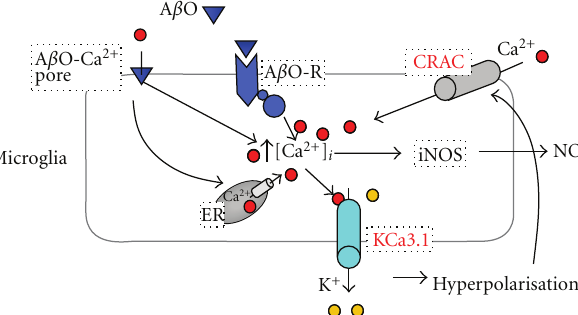
Figure 1: KCa3.1 regulates microglial activation by modulating Ca 2+ influx. A β O initiates an increase of intracellular Ca 2+ either directly by forming a Ca 2+ -permeable membrane pore (A β O-Ca 2+ pore) [11, 12] or indirectly through interaction with a receptor (tentatively termed A β O-R). Intracellular Ca 2+ activates KCa3.1 to induce K + e ffl ux. The resulting hyperpolarisation provides the driving force for Ca 2+